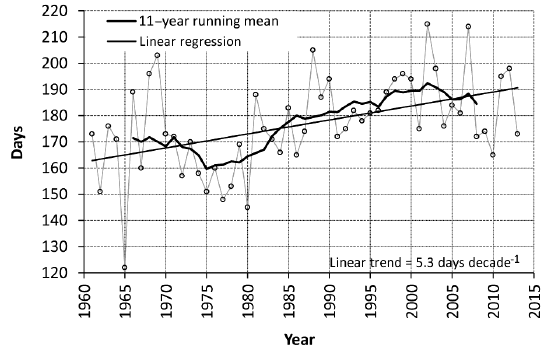
Figure 6. Days per year with maximum air temperature exceeding 0 ◦ C at 3000ma.s.l., calculated from the series of the Careser Diga weather station (2600ma.s.l., Ortles-Cevedale